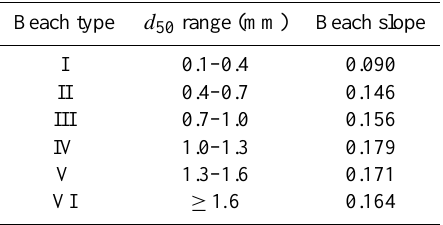
Table 1. Beach classes along the Catalan coast in terms of sediment size and beach slope.